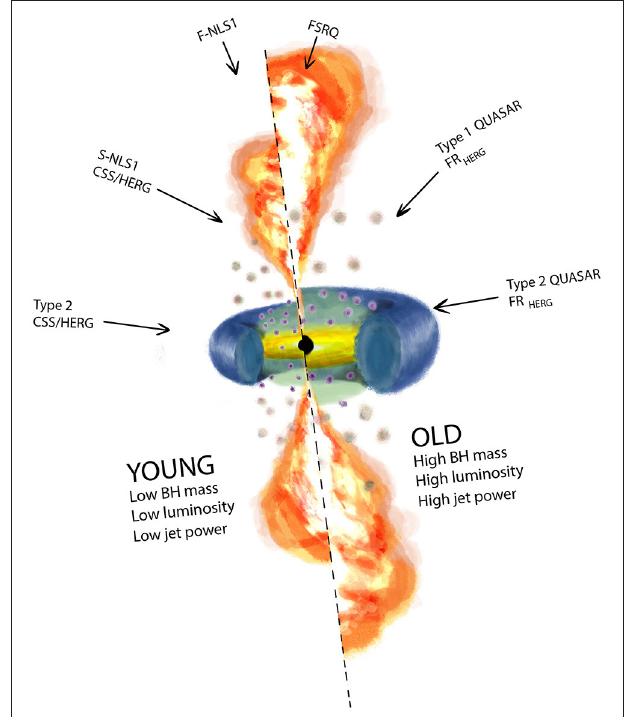
FIGURE 3 | Unification scheme of jetted-AGN with high accretion rate with respect to the Eddington limit and a high-density photon-rich environment. On the left side, young and smaller sources (NLS1s and CSS sources), compared to older and larger objects (FSRQs and FR HERG ).